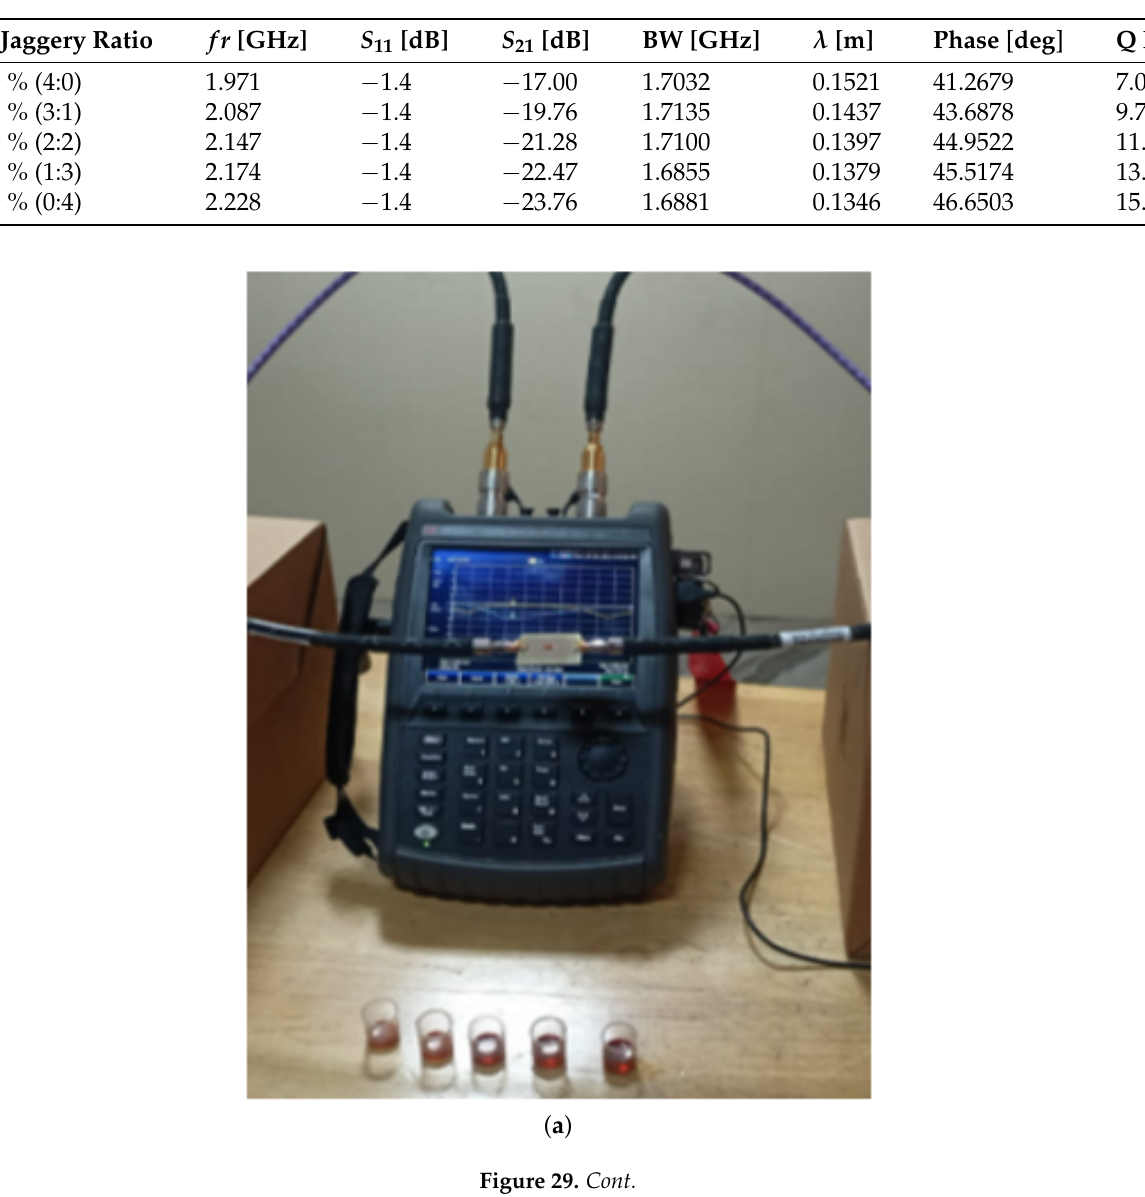
Table 11. Adulteration testing in honey.